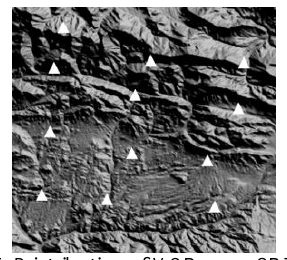
Figure 6. (a): Scatter plot of the height residuals when VCPs conjugate point determination performed manually, (b): when VCPs conjugate points derived by least square image matching.